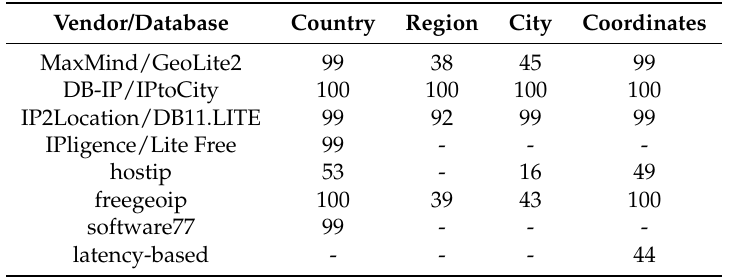
Table 5. Location efficiency—returned correct or incorrect locations